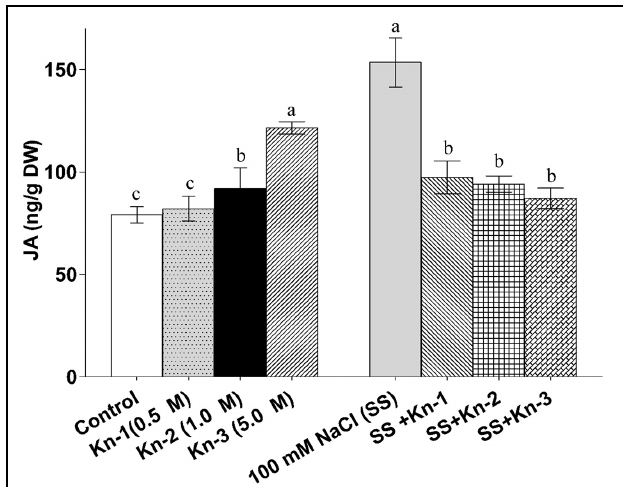
FIGURE 8 | Effect of exogenous application of Kn and NaCl on the endogenous level of Jasmonic acid (JA) of soybean shoots. Seedlings of soybean were exposed to different concentrations of Kn and NaCl after 17 days of sowing (17 DAS) and harvested after 24 h. Graph represents data from nine replicates in two independent experiments (data are mean ± SD; n = 18). Bars labeled with different letters shows significant difference ( p < 0.05; Duncan